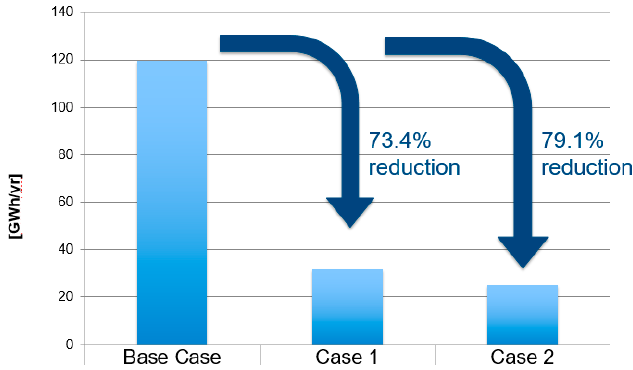
Figure 14. Comparison of wind curtailment in different cases.